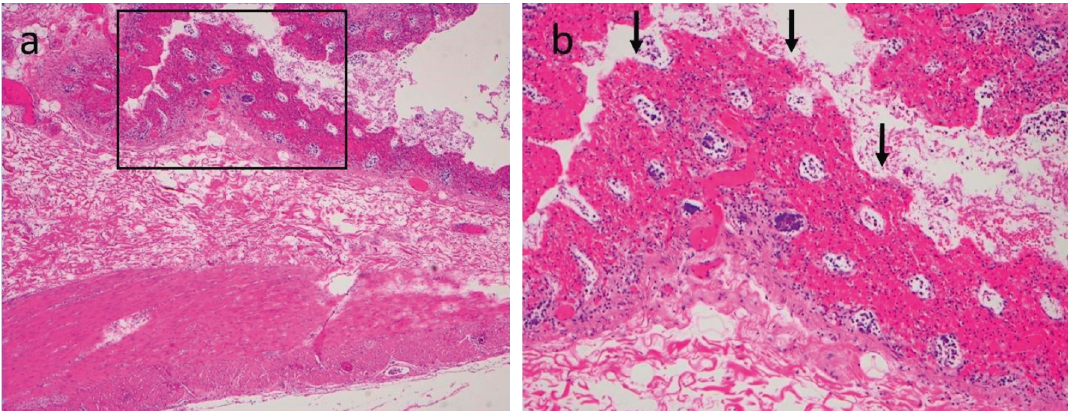
Figure 3: Histopathological findings of the colonic wall. (a) 20x magnification. (b) 100x magnification (inset). Transmural ischemic necrosis with hemorrhages is indicated by the arrows (hematoxylin and eosin